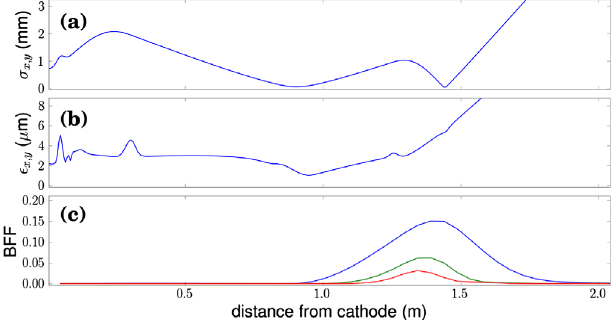
FIG. 8. Transverse horizontal σ x and vertical σ y rms beam sizes (a), corresponding transverse emittances (b) and bunch form factor (BFF) (c) evolution along the beam line. The BFF is evaluated at f 1 ¼ 1 THz (blue trace) and at the second (green trace) and third (red trace) harmonics. The simulations corre- spond to the parameters listed under the S -band column